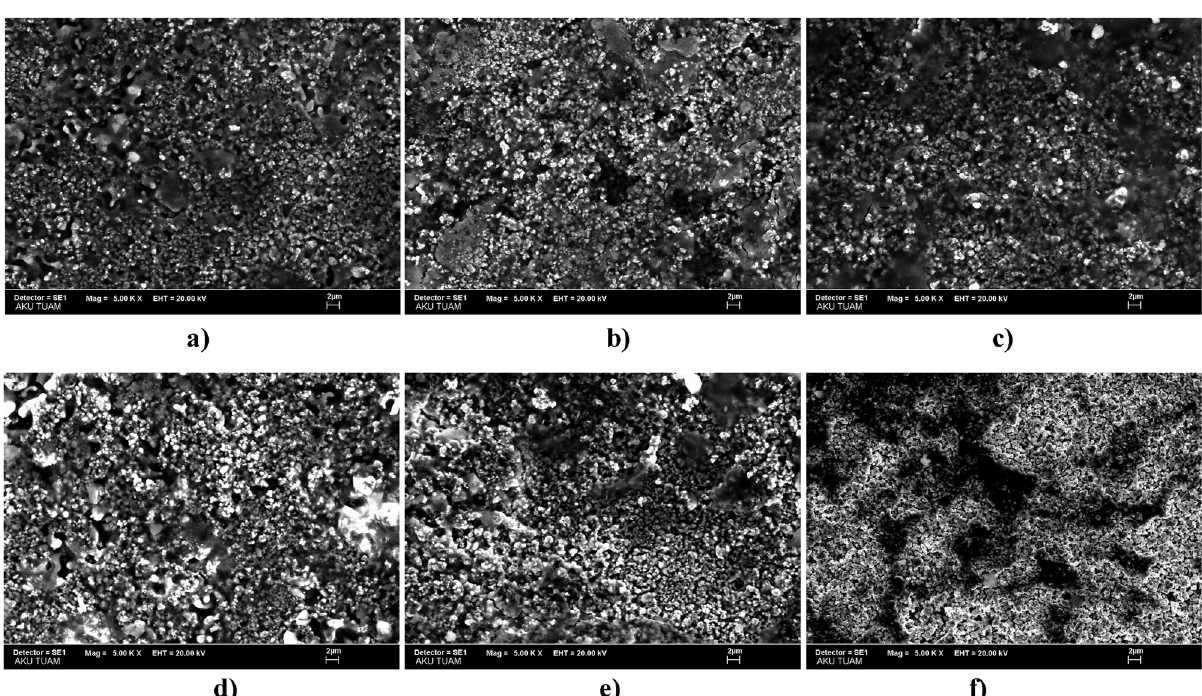
Figure 4: SEM Images of ( a ) C1, ( b ) C2, ( c ) C3, ( d ) C4, ( e ) C5, and ( f ) C6